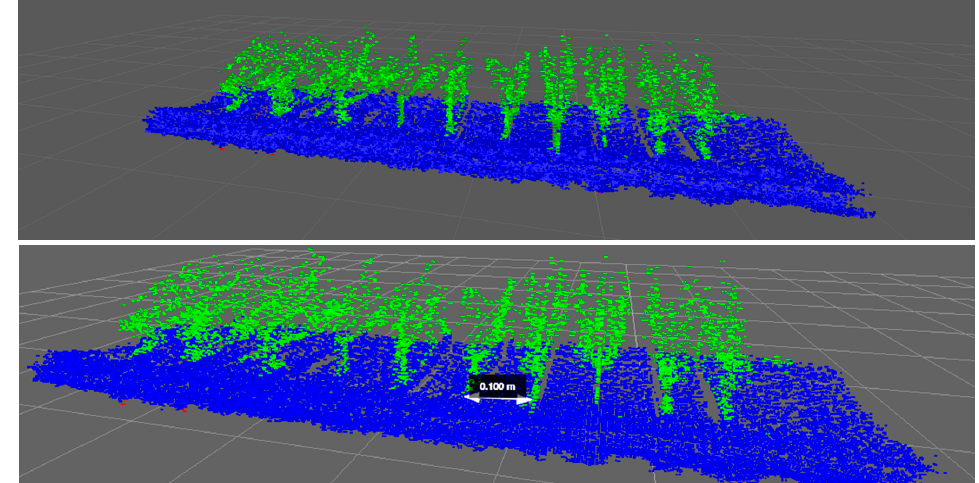
Figure 8. Point cloud representation of artificial 3D plants obtained using a lateral-scanning LiDAR sensor during laboratory tests.